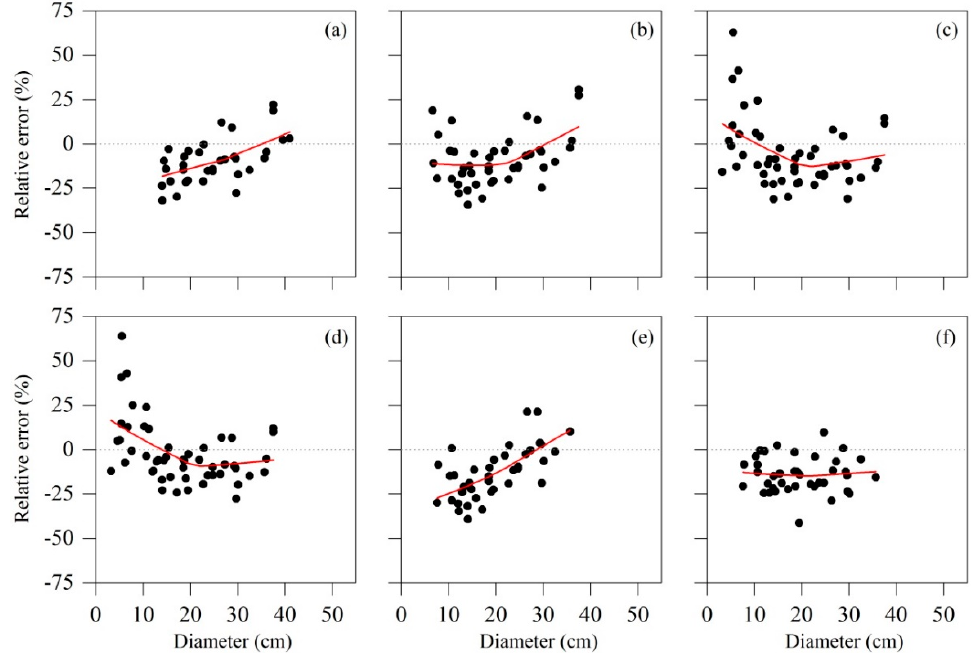
Figure 6. Relative error in the prediction of total aboveground biomass versus dbh for trees with dbh belongs to the model application range measured in this study. Predictions errors were calculated for the six models displayed in Table 3: ( a ) equation by Wang [18], ( b ) equation by Dong et al. [49], ( c ) equation by Zeng [51] using only dbh as predictor, ( d ) equation by Zeng [51] using both dbh and h as predictor, ( e ) equation by Dong et al. [50] using only dbh as predictor, ( f ) equation by Dong et al. [50] using both dbh and h as predictor. Red solid lines are smoothed errors using a lowess method.